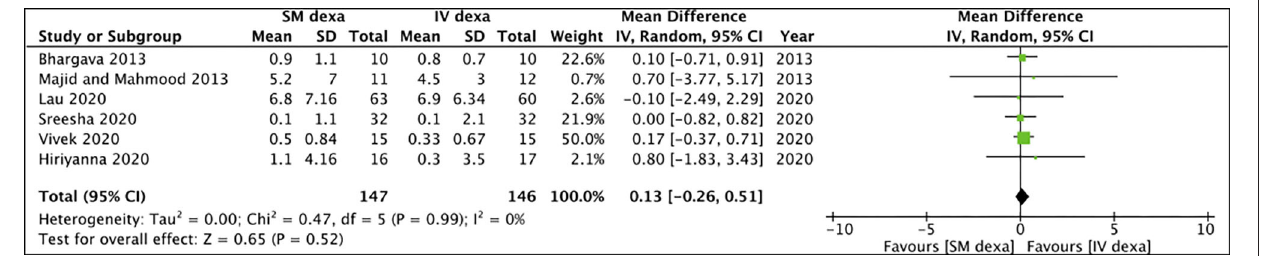
FIGURE 7 | Meta-analysis of late trismus between SM and IM dexamethasone (dexa) for third molar surgeries.